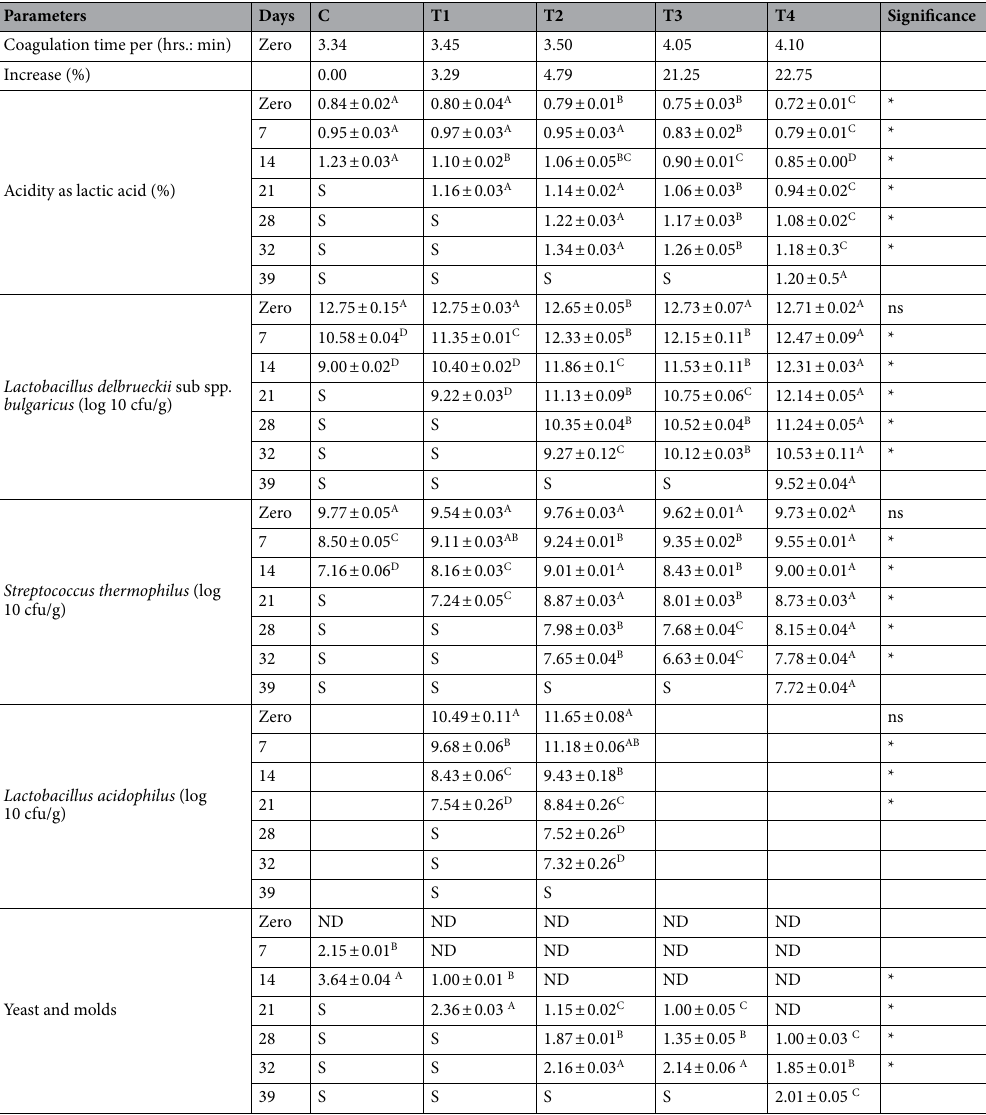
Table 1. Evaluation of the different yogurt treatments during cold storage: coagulation time, acidity, viability of starter bacteria, Lactobacillus acidophilus , and occurrence of yeast and molds. C: 2% yogurt starter cultures 1:1 (control). T1: 1% yogurt starter cultures 1:1 + 1% Lb. acidophilus. T2: 1% yogurt starter cultures 1:1 + 1% Lb. acidophilus + 2% inulin + 2% FOS. T3: 1% yogurt starter cultures 1:1 + 1% Lb. acidophilus bacteriocin. T4: 1% yogurt starter cultures 1:1 + 1% Lb. acidophilus bacteriocin + 2% inulin + 2% FOS. *The values indicated are the mean ± S.E (n = 3). Values in the same raw denoted by different letters (ABCD) differ significantly (p < 0.05) from each other. S spoilage, ND not detected, ns